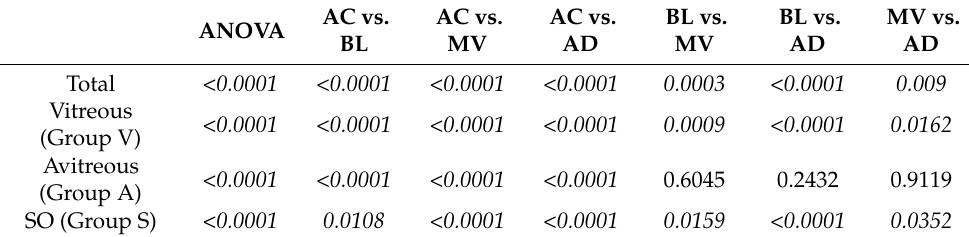
Figure 2. Distribution of the intraocular temperature at the beginning of vitrectomy in all eyes. The temperature was lower at the more anterior part of the eye. AC, anterior chamber, BL, behind lens; MV, mid-vitreous; OD; just anterior to the optic disc. Table 2. Comparison of temperature between intraocular